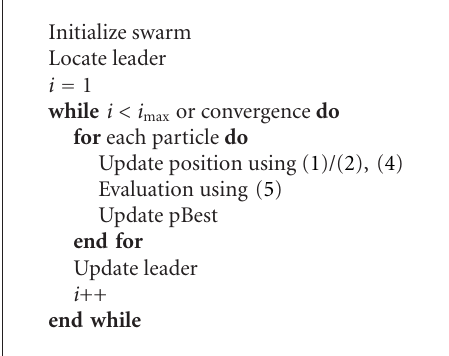
Algorithm 1: Standard PSO